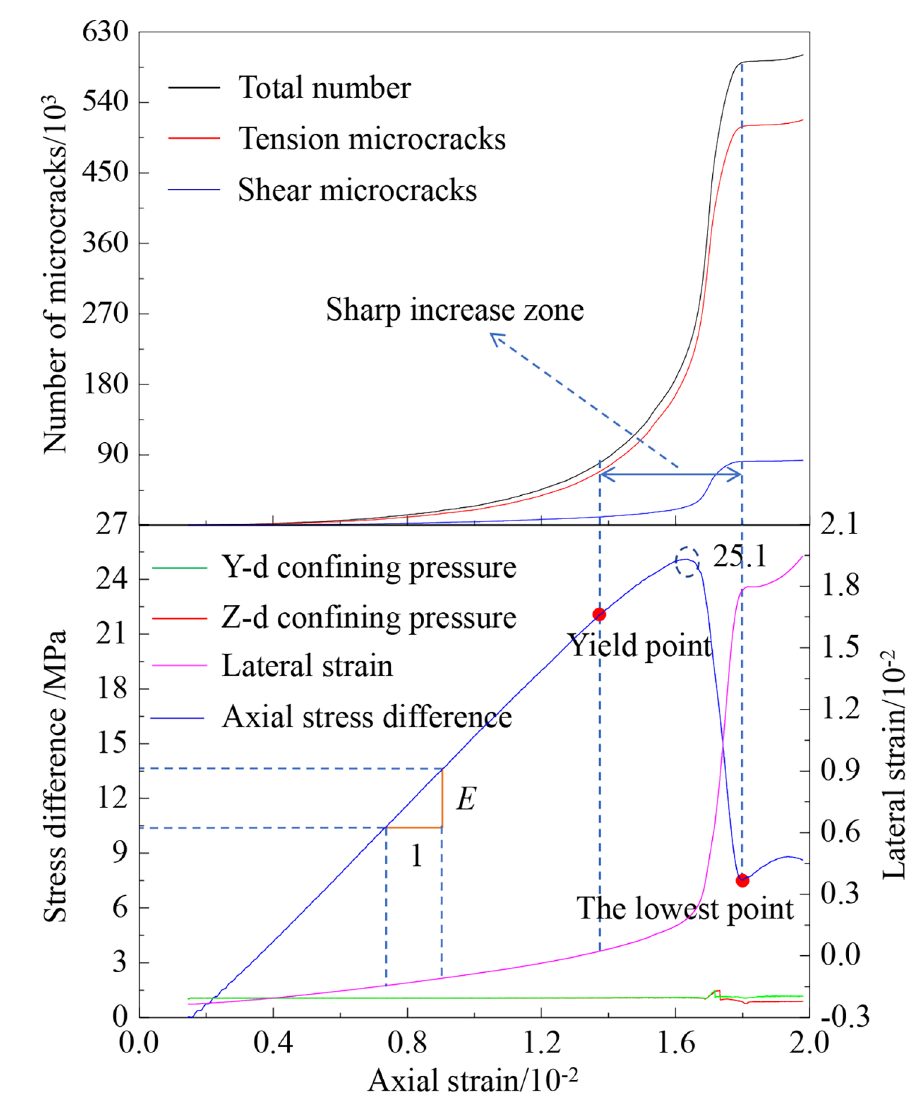
Fig. 12 Numerical results of stress and strain for jointed coal with REV size after triaxial com - pression with loading perpen- dicular to butt cleats. Y -d and Z -d refer to the Y - and Z -directions,